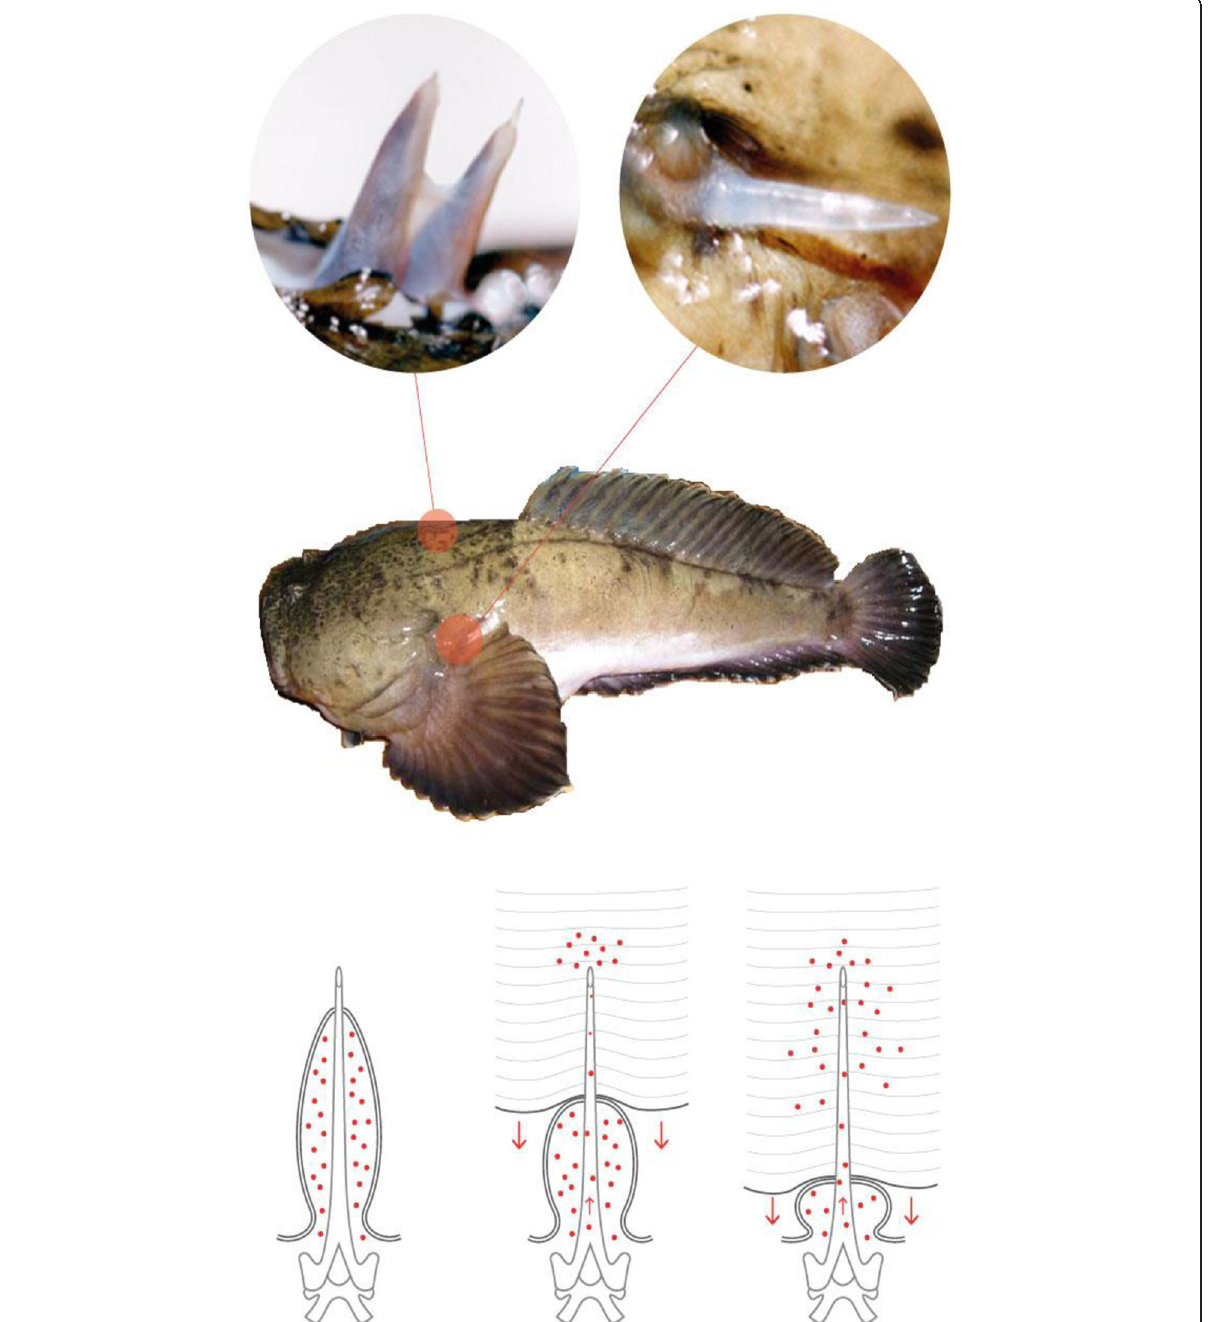
Figure 1 The venom apparatus of Thalassophryne nattereri is composed of two dorsal and two lateral canaliculated spines covered by a membrane connected to the venom glands at the base of the fins. When the spine penetrates the victim, the integumentary sheath enclosing the gland press out the venom into the